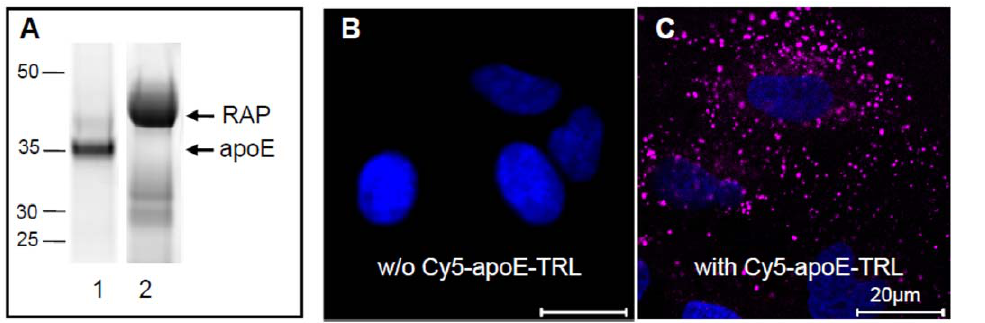
Figure 2. TRL-derived apoE is internalized into peripheral endosomal compartments. Cy5-apoE-TRL and Cy3-RAP were prepared and protein labelling was analyzed by SDS-PAGE and subsequent in-gel fluorescence detection (A). Incubation of HuH7 cells without (B) and with Cy5- apoE-TRL (C) for 30 min at 37 u C resulted in a punctuated endosomal pattern indicating receptor-mediated endocytosis. Nuclei were visualized by DAPI and appear in blue. Bar is 20 m m.